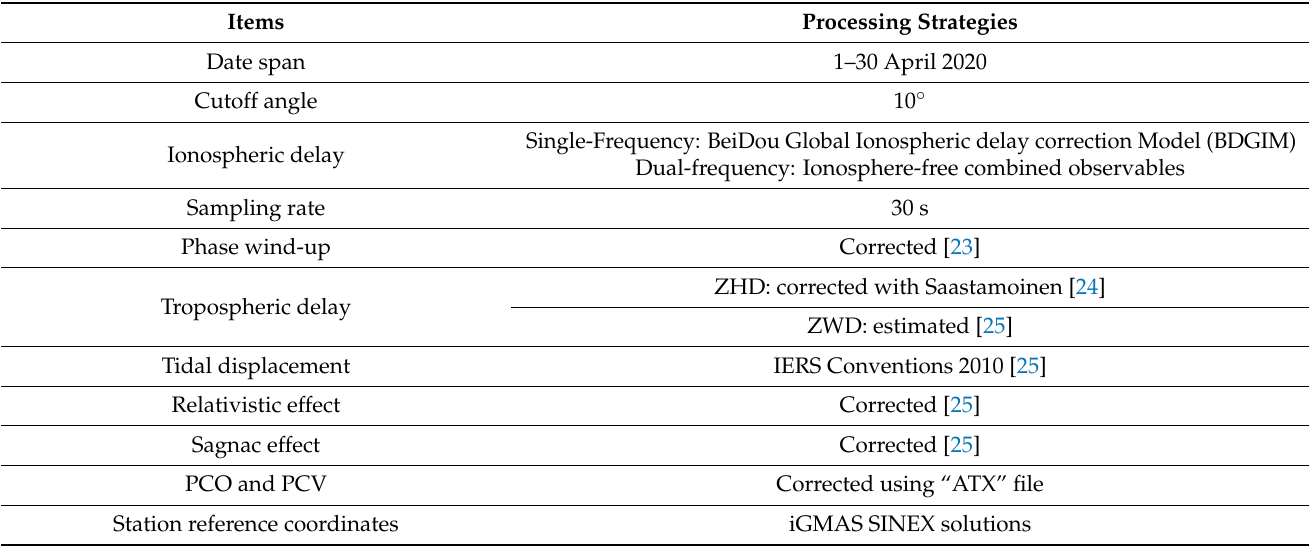
Table 1. The summary of BDS-3 SPP and PPP processing strategies.